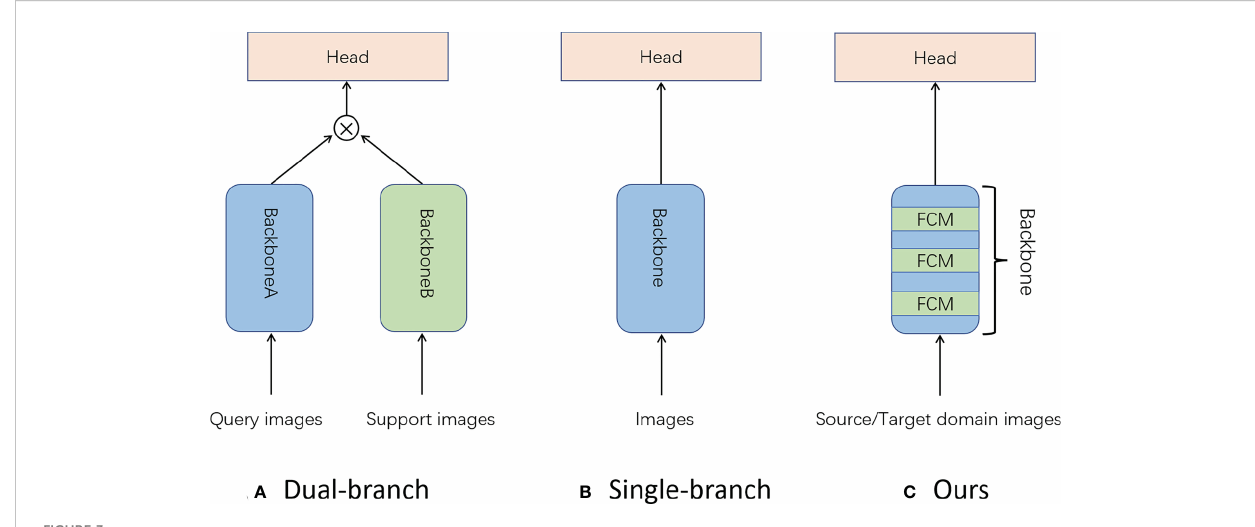
FIGURE 3 The comparison among two typical few-shot learning structures and